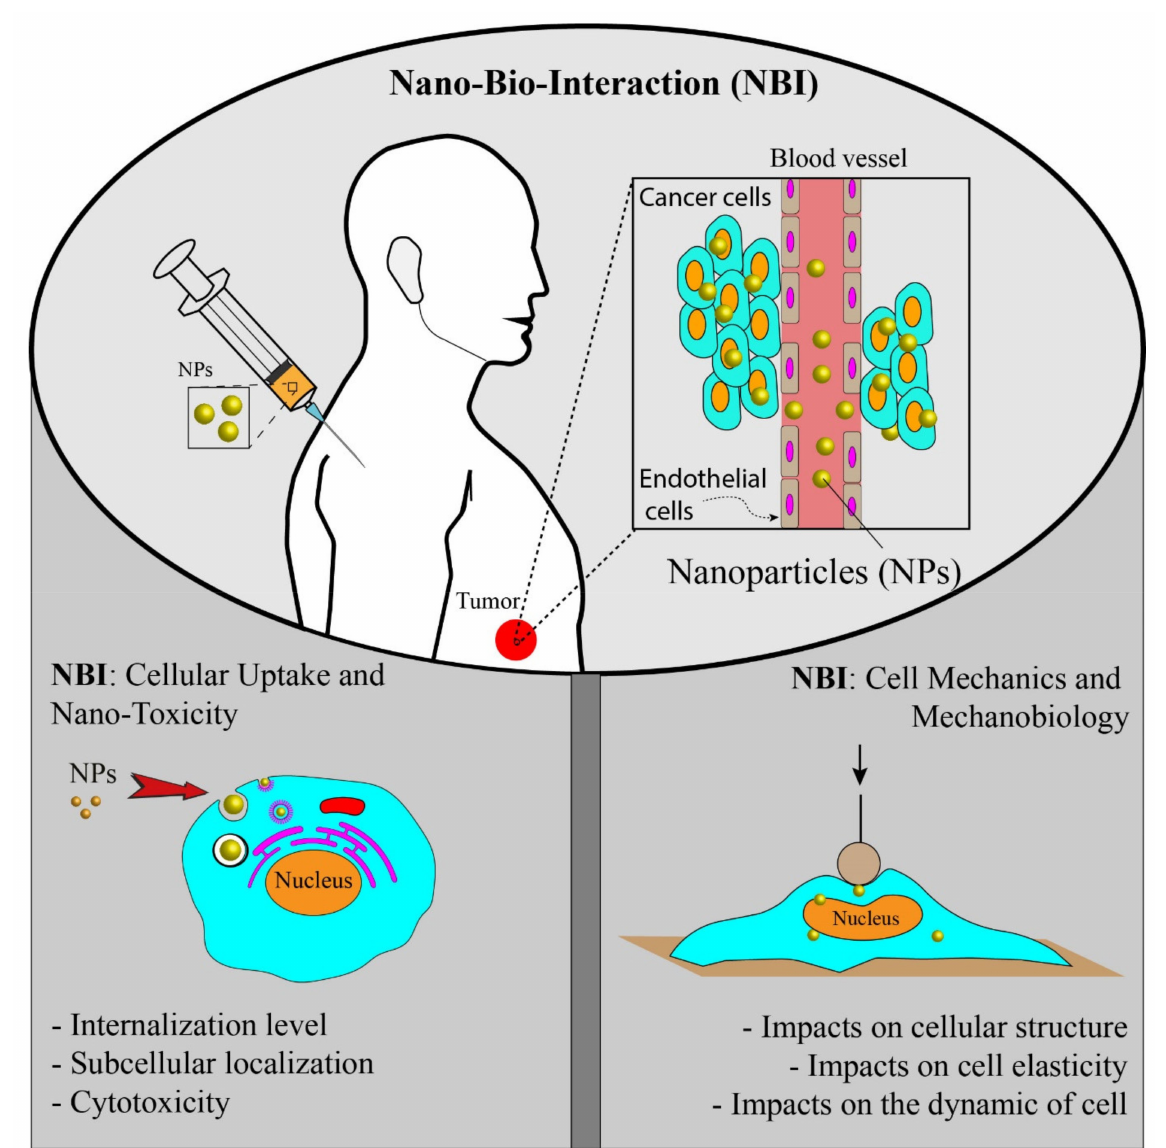
Figure 1. Nano-bio-interaction from two different aspects: (1) study of the cellular uptake and toxicity, (2) study of the mechanics and mechanobiology of cells due to the cellular uptake of